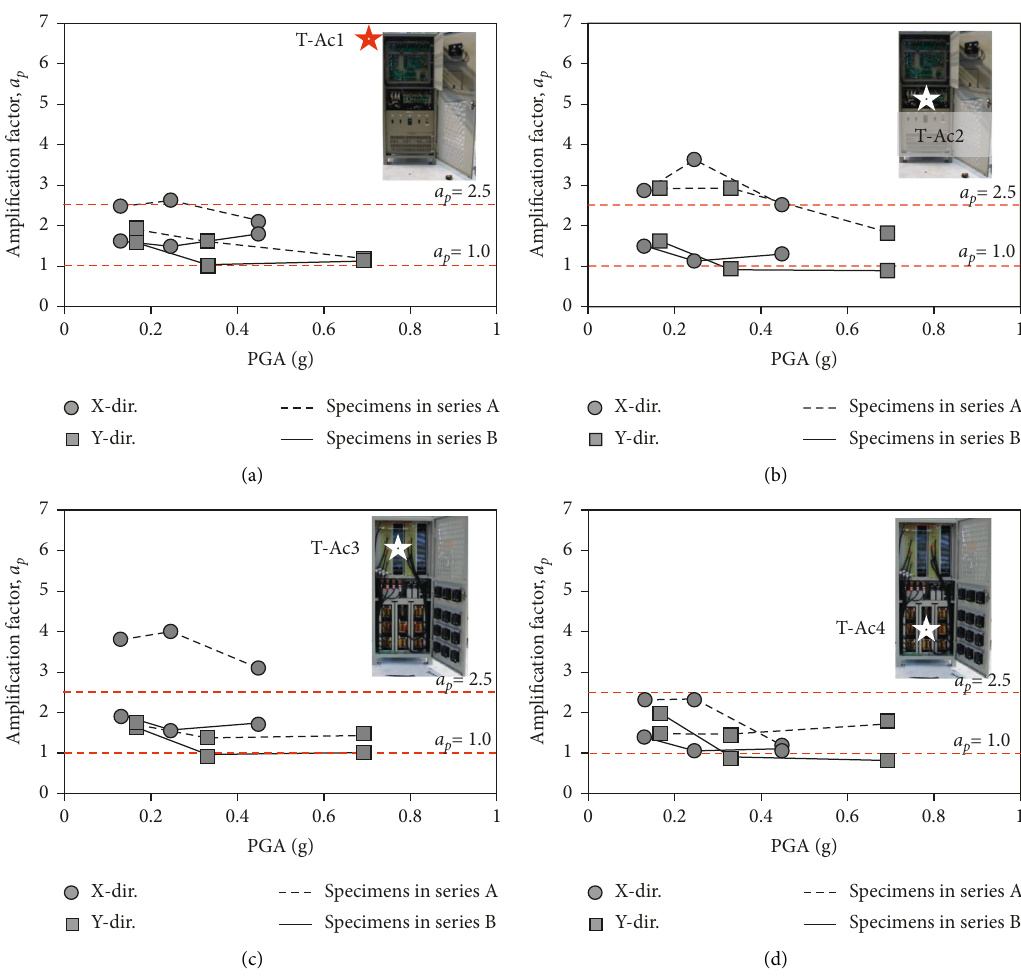
Figure 15: Amplification factor versus PGA at different locations of the test specimens in Series A and B. (a) At the top of the UPS. (b) At the control switch. (c) At the cooling system. (d) At the